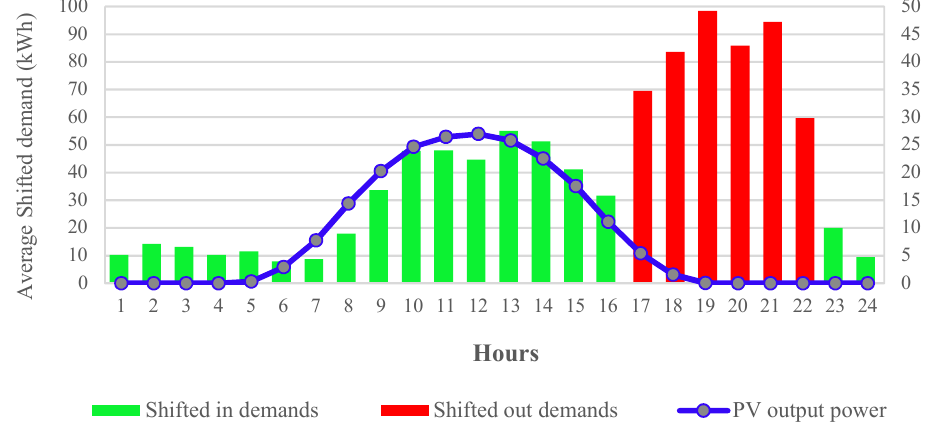
Figure 9. Total shifted cumulative demand versus average power output of a PV module for a one-year horizon.